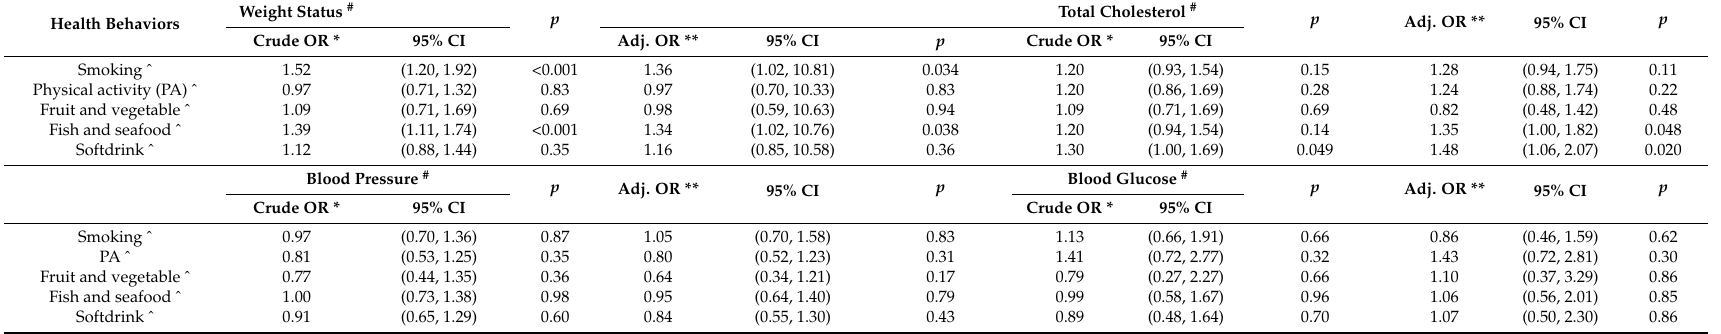
Table 5. Associations between health behaviors and cardiovascular health factors (logistic regressions) a . CI—confidence